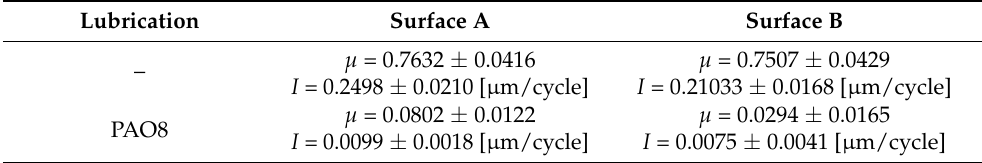
Table 6. Tribological characteristics—average value with standard